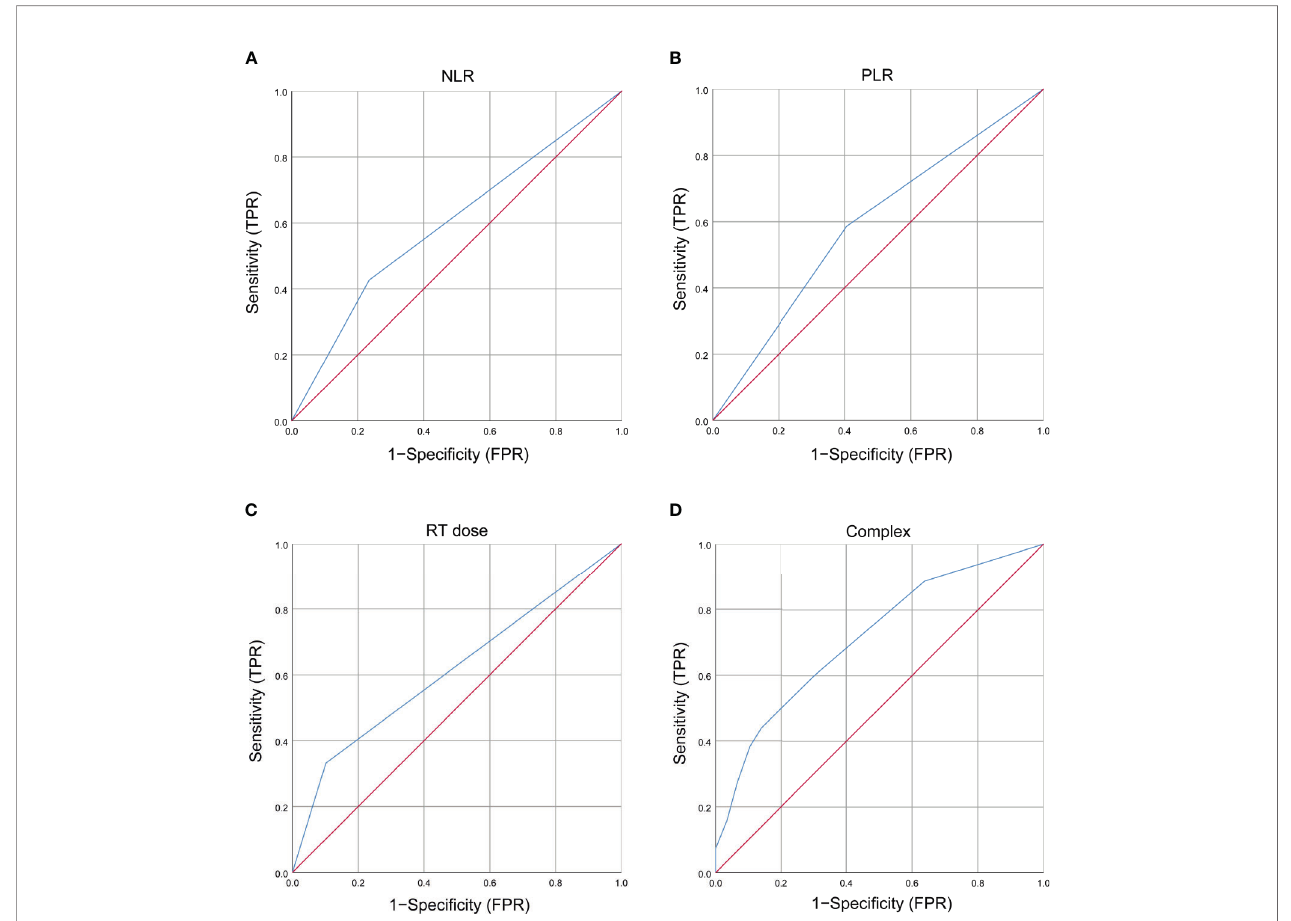
FIGURE 1 | Receiver operating characteristic (ROC) curves of clinical and dosimetric factors, in fl ammation index, and complex for grade ≥ 2 RE. (A) ROC curves of NLR; (B) ROC curves of PLR; (C) ROC curves of RT dose; (D) T ROC curves of complex (NLR, PLR, and RT dose). RT, radiotherapy; NLR, neutrophils-lymphocyte ratio; PLR, platelets-lymphocytes ratio; RE, radiation esophagitis; FPR, false positive rate; TPR, true positive